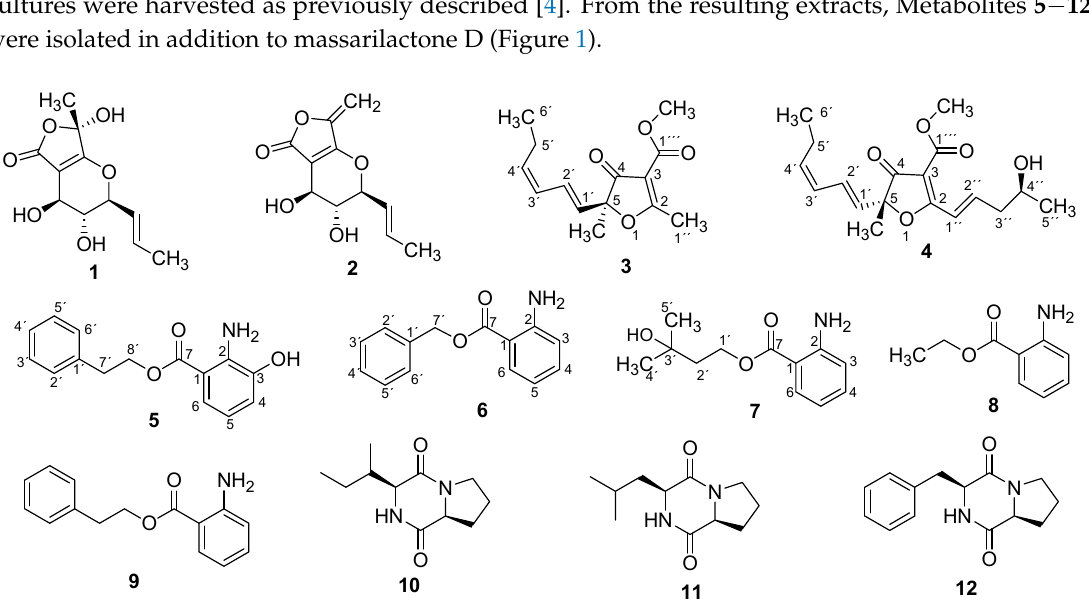
Figure 1. Structures of secondary metabolites isolated from Dendrothyrium variisporum .